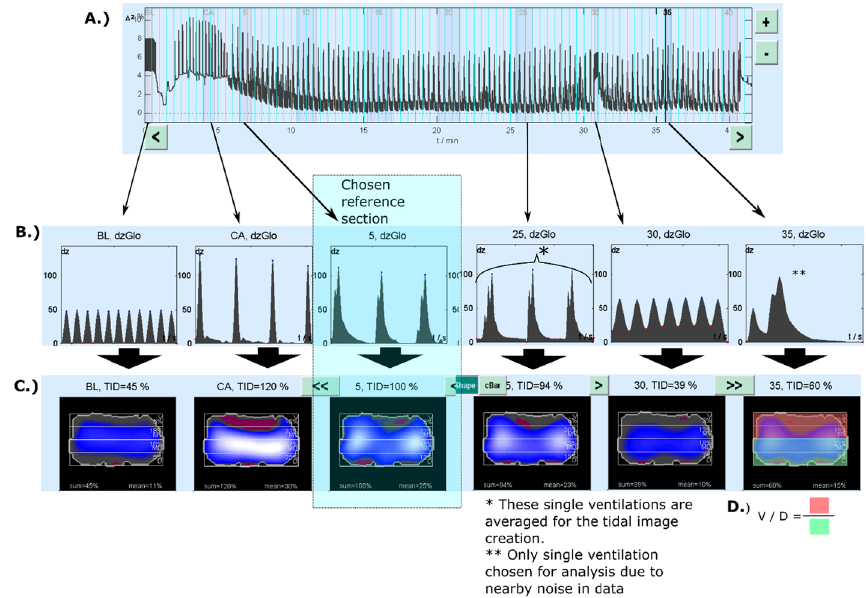
Fig. 2 Schematic illustration of the EIT analysis work chart. A The raw dzGlo curve. B The reconstructed sections after filtering. C Visual slices created with the automated analysis scheme from filtered sections. D Visual explanation of the V/D index. BL: baseline; dzGlo: global impedance change; TID: tidal impedance change; CA: cardiac arrest; V/D: ventral per